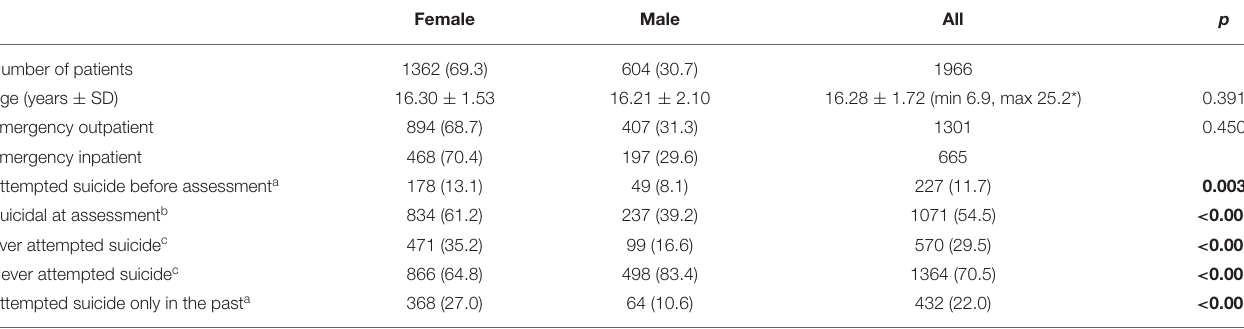
TABLE 1 | Descriptive statistics of all the consecutive patients assessed as outpatients and admitted to the hospital from March 1 st 2019 until July 31 st 2021. Female Male